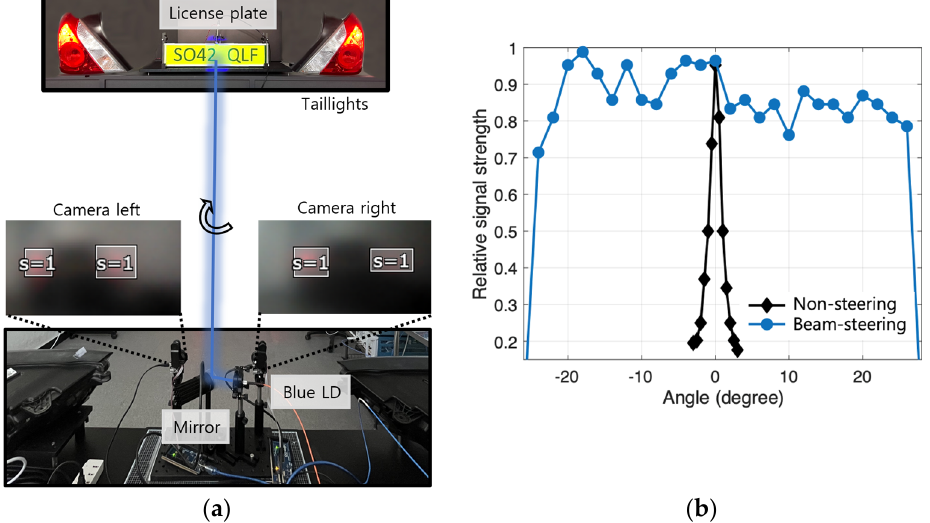
Figure 6. ( a ) Comparison of received signal strength with and without beam steering; ( b ) Beam- steering and tracking setup.